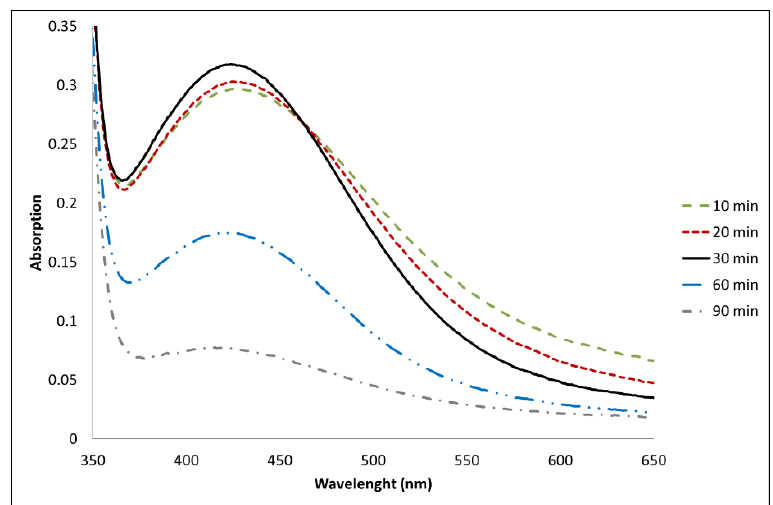
Figure 1. UV-Vis spectrum of a 0.4 M solution of AgNO 3 in DMF over time: AgNPs in a size range of 10 – 30 nm give a plasmon resonance peak at 420 – 430 nm.